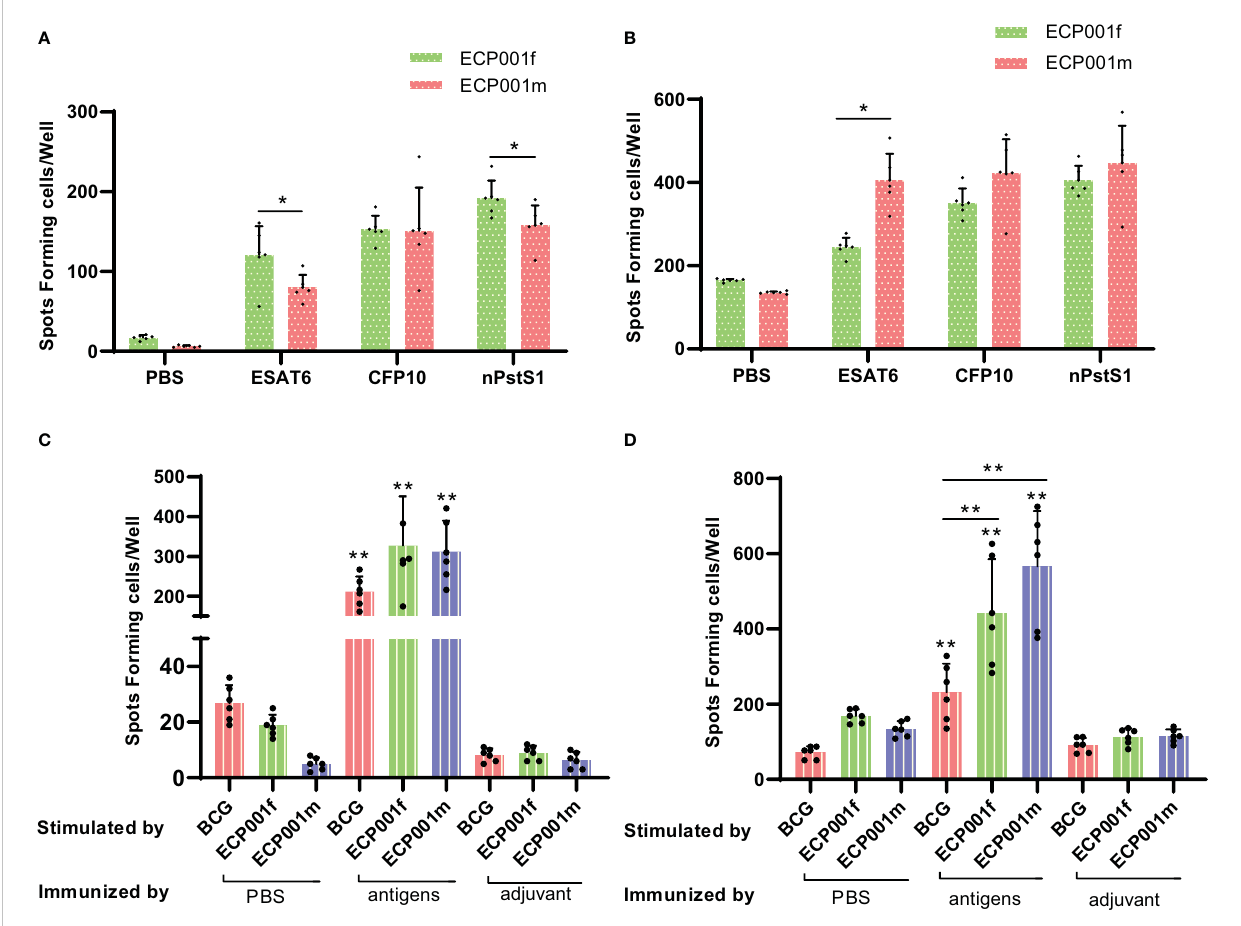
FIGURE 5 The number of IFN- g and IL-4 secreted by mouse spleen cells stimulated by antigen or BCG whole cell lysate. The number of IFN- g (A) and IL-4 (B) secreted by mouse spleen cells stimulated by three kinds of single antigens, and the number of IFN- g (C) and IL-4 (D) secreted by mouse spleen cells stimulated by ECP001f, ECP001m and BCG whole cell lysate. The signi fi cant statistical difference between the vaccine or BCG whole cell lysate group and the PBS/adjuvant control group was indicated by the asterisk above the antigen group, and the signi fi cant statistical difference between the ECP001f, ECP001m group and the BCG group was indicated by the asterisk above the line between the two groups. (* P < 0.05, ** P